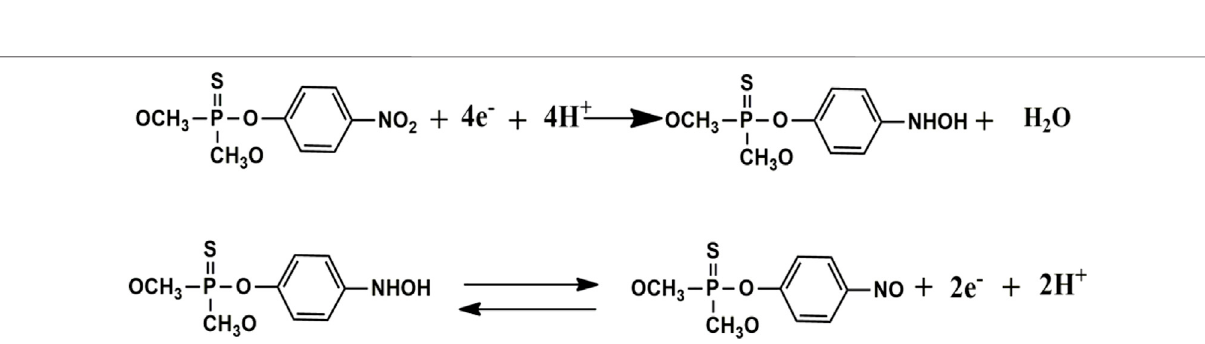
FIGURE 7 | Chemical mechanism of methyl parathion reduction.